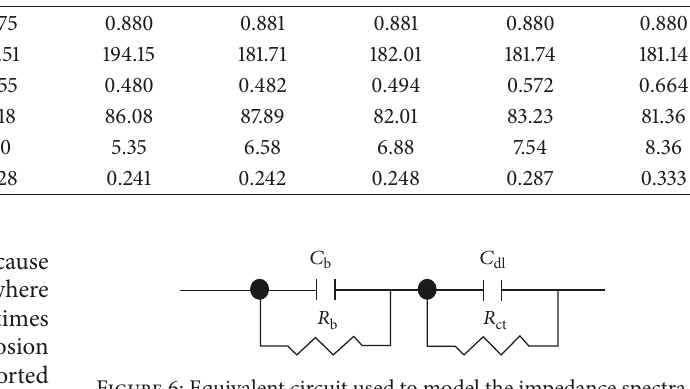
Figure 6: Equivalent circuit used to model the impedance